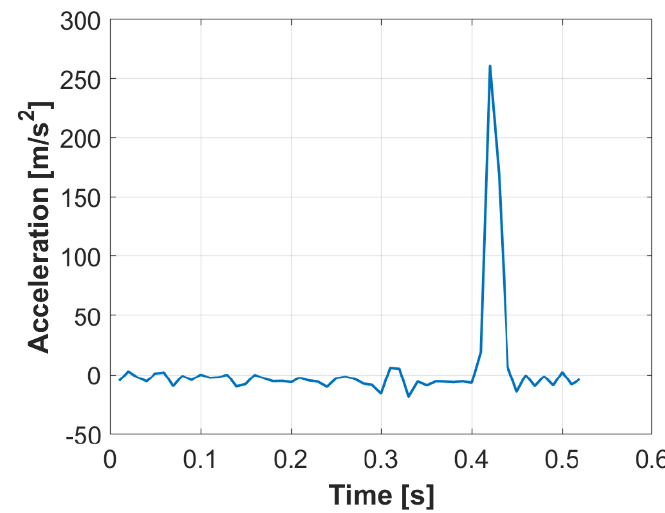
Figure 8. Instantaneous ball acceleration obtained by differentiating the velocity signal with respect to time, for one header (impact point at 0.43 s).